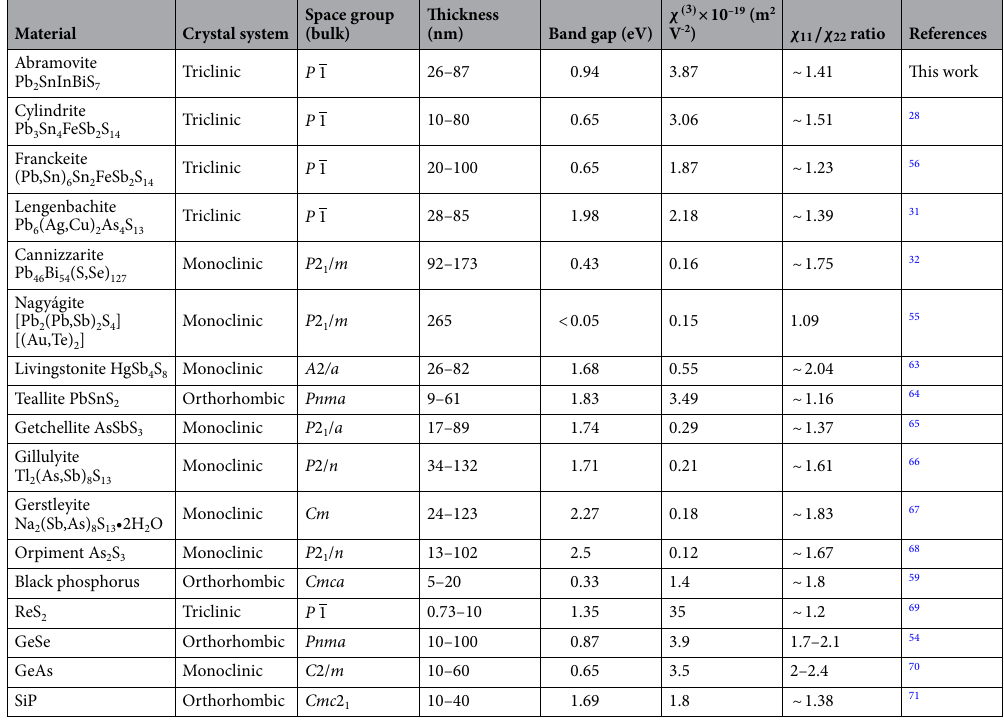
Table 2. Comparison of third-order nonlinear susceptibility in abramovite with other anisotropic vdW materials at the fundamental wavelength around 1560